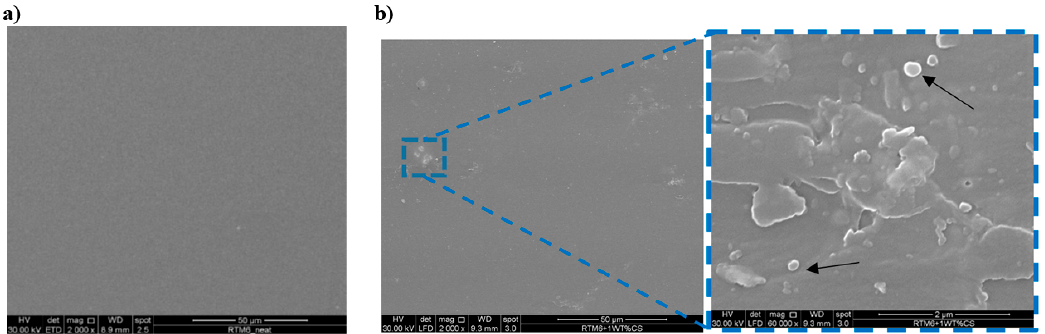
Figure 13. SEM micrographics of ( a ) neat epoxy resin and ( b ) RTM6 + 1 wt% CSNPs: the zoom in ( b ) clearly shows the CSNPs (black arrows).